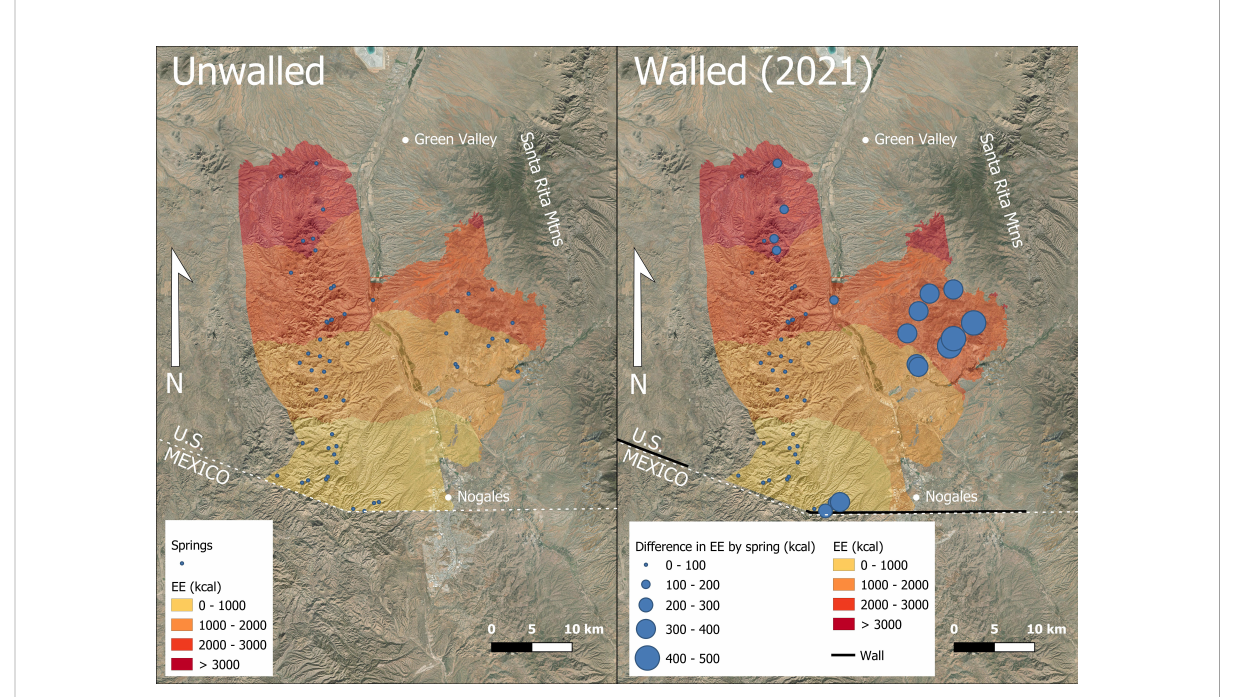
FIGURE 2 Cumulative jaguar energy expenditure (kcal) from the border north pre-wall (left) and with walls as of 2021 (right) in the United States portion of the Critical habitat crossings corridor for our case study around Nogales, Arizona. Spring locations post-wall are symbolized by difference in EE from pre-wall scenario (Chambers et al., 2022b).